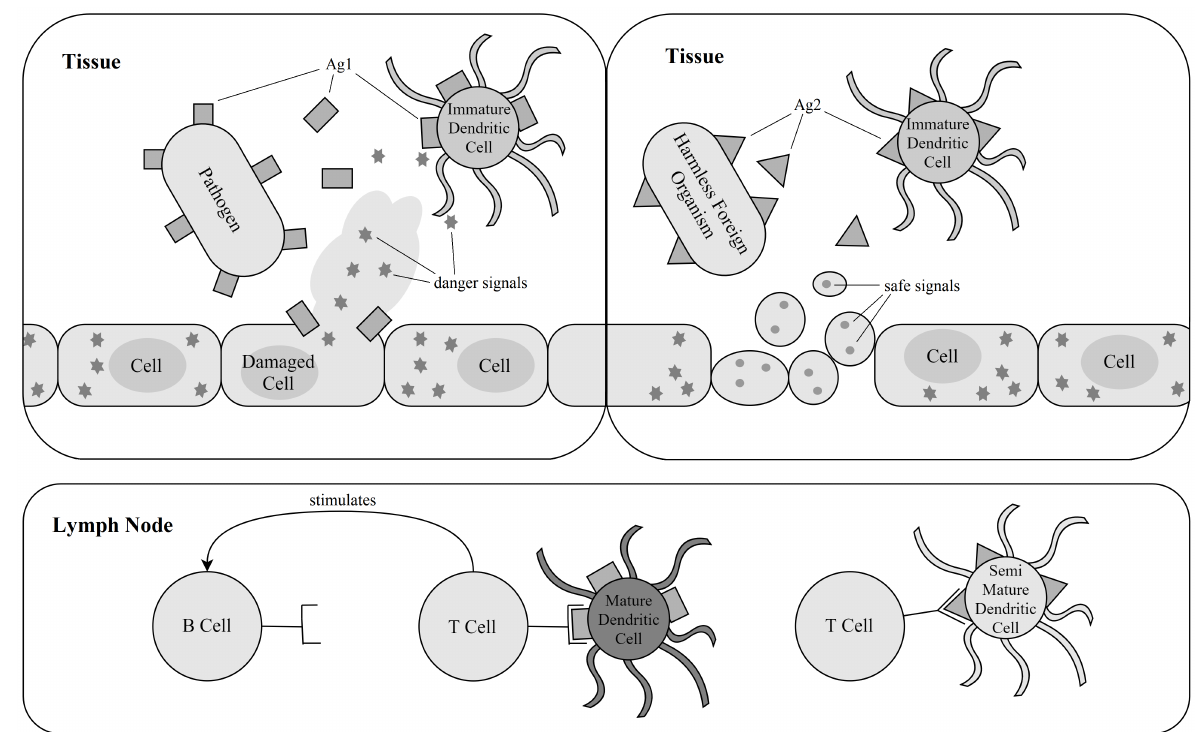
Figure 5. Simplified model of the danger theory. Note that immature dendritic cells ( iDCs ) collect a vast variety of antigens , not just one specific type, as illustrated for simplicity purposes. Initially, iDCs navigate throughout the body, collecting encountered antigens without discriminating between self or non-self. While navigating, iDCs also collect signals emitted by dying tissue cells. Damaged cells release chaotically their contents, which are identified as danger signals by neighboring iDCs . On the other hand, when cell death is programmed, iDCs still collect antigens while recognizing safe signals